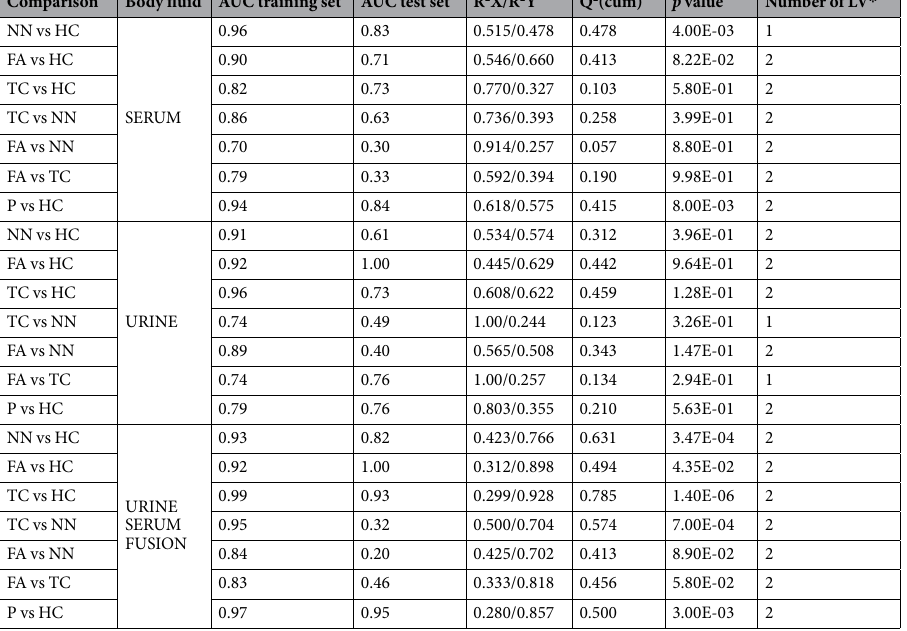
Table 2. The parameters of PLS-DA models obtained from 1 H NMR analysis of serum, urine samples and fusion data ( * latent